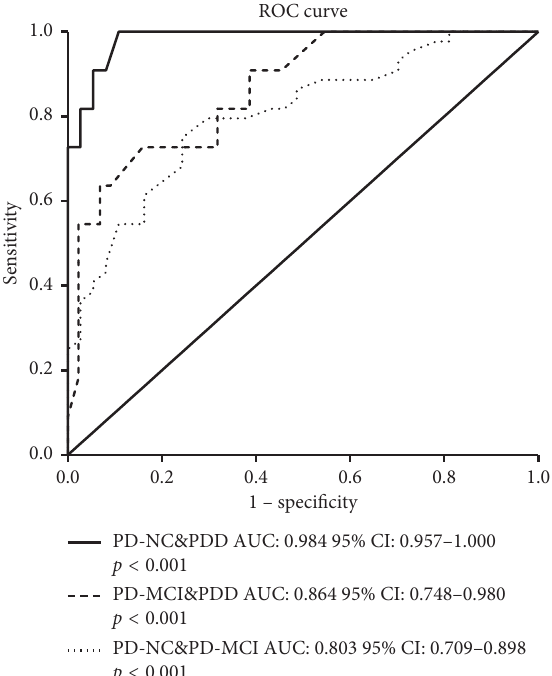
Figure 2: Discriminative power of PD-CRS for diagnosing PD-MCI and PDD. AUC for differentiating PD-MCI is 0.803, 95% CI: 0.709–0.898, p < 0 . 001. AUC for detecting PDD is 0.984, 95% CI: 0.957–1.000, p < 0 . 001.